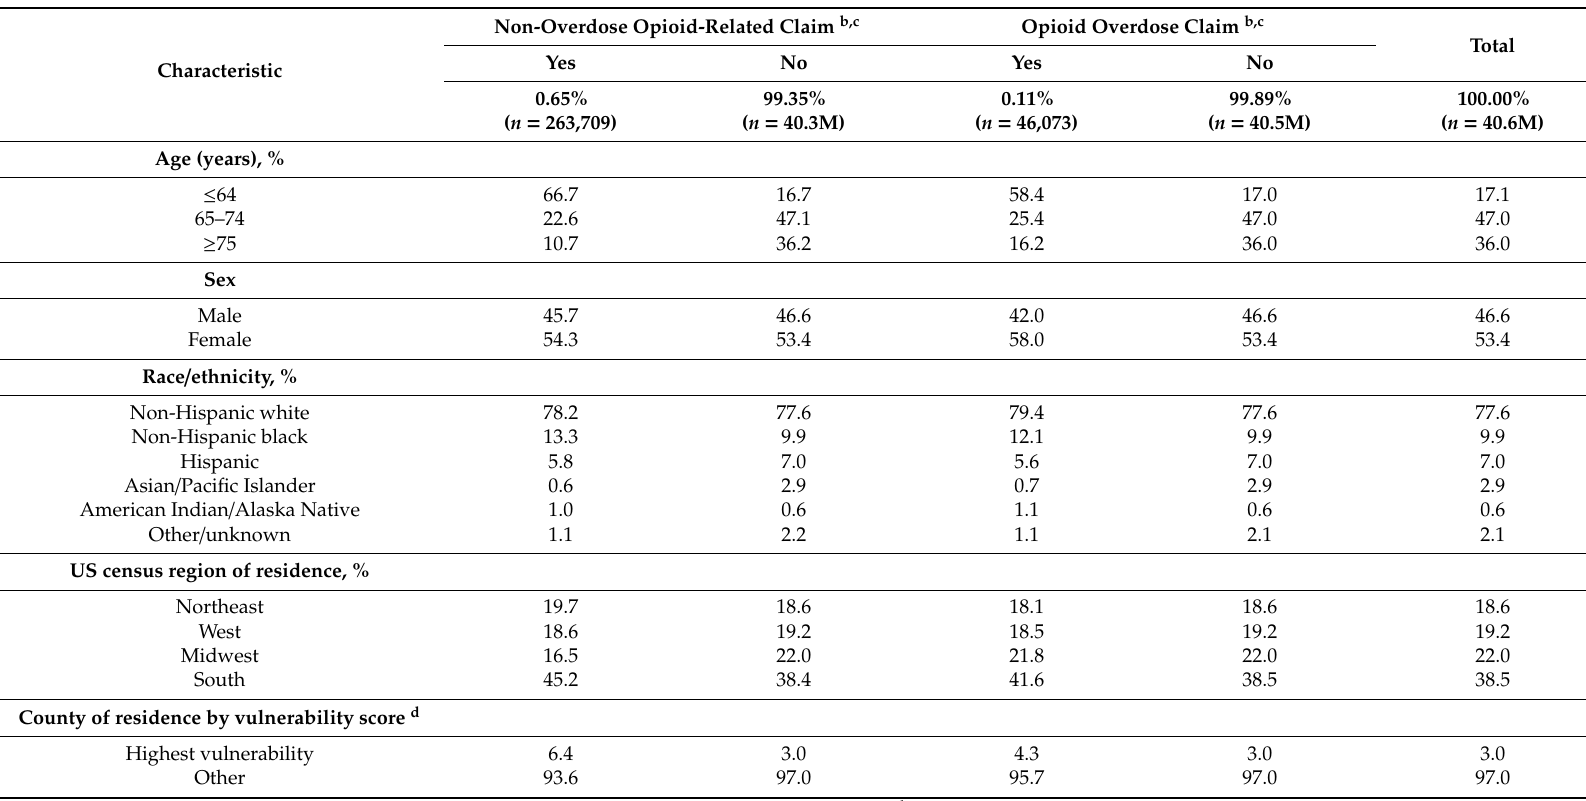
Table 1. Percentage of Medicare fee-for-service beneficiaries with and without claims a for opioid-related diagnoses, by demographic attributes, United States, 2015.